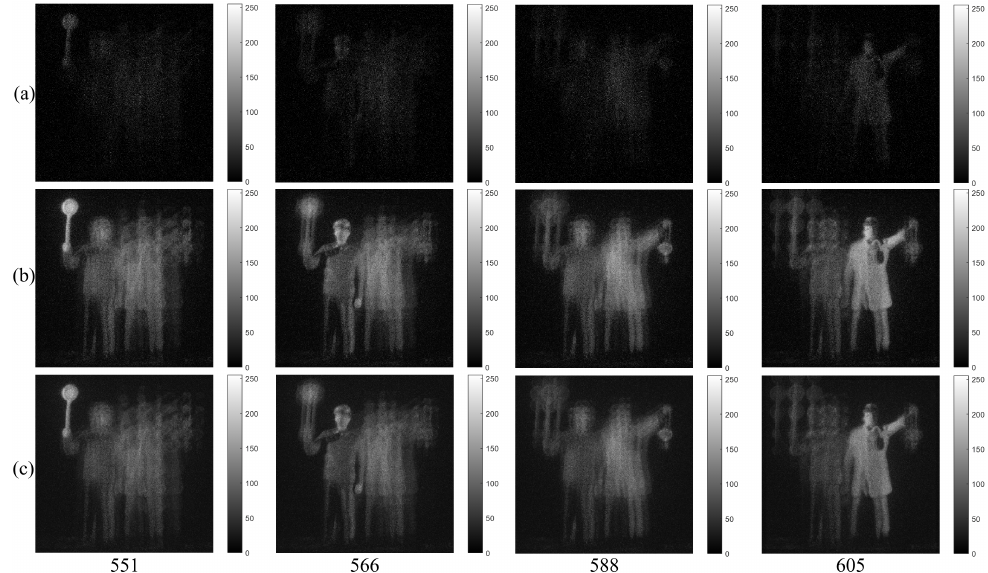
Figure 13. 3D images under photon-starved conditions of Men objects with 1% photon ratio and various spatial periods at reconstruction depths by ( a ) the single observation photon counting images ( b ) N = 100 observation photon counting images by MLE and ( c ) N = 100 observation photon counting images by MAP,